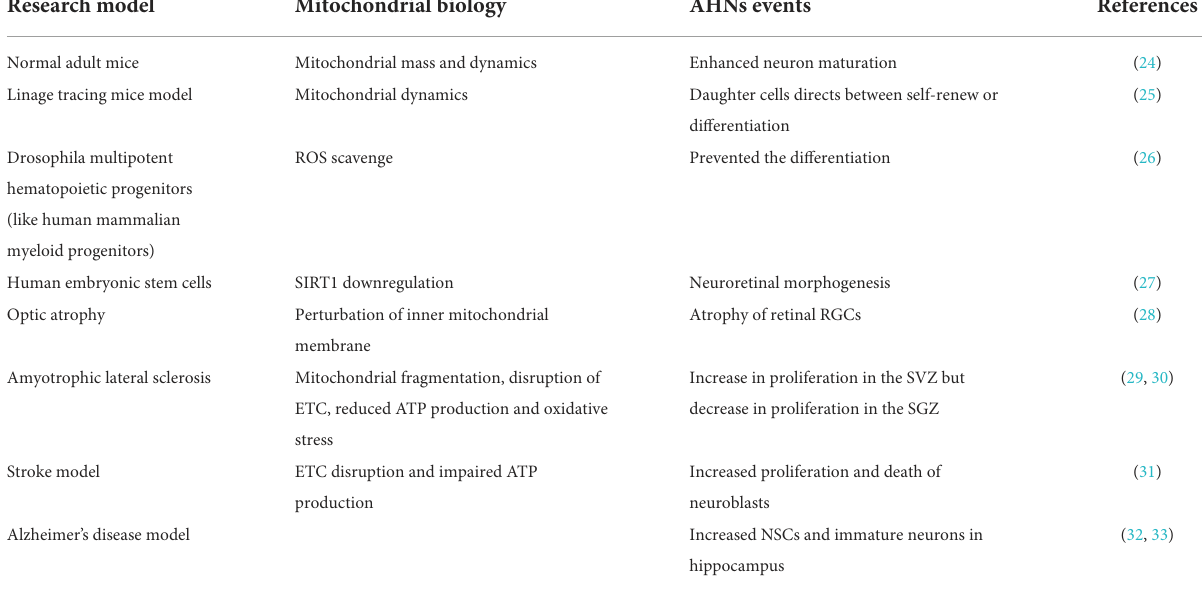
TABLE 1 Mitochondrial biology in regulating AHNs in different